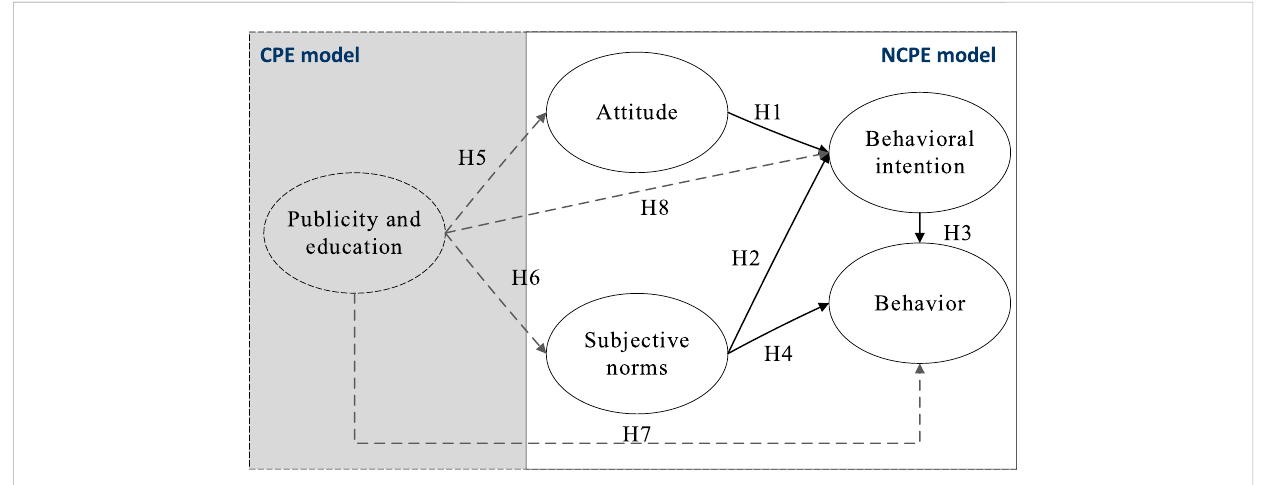
FIGURE 1 Research framework andhypotheses.Notes:CPE modelrepresents themodelconducting “ Publicity andeducation, ” andNCPE representsamodel without “ Publicity and education.